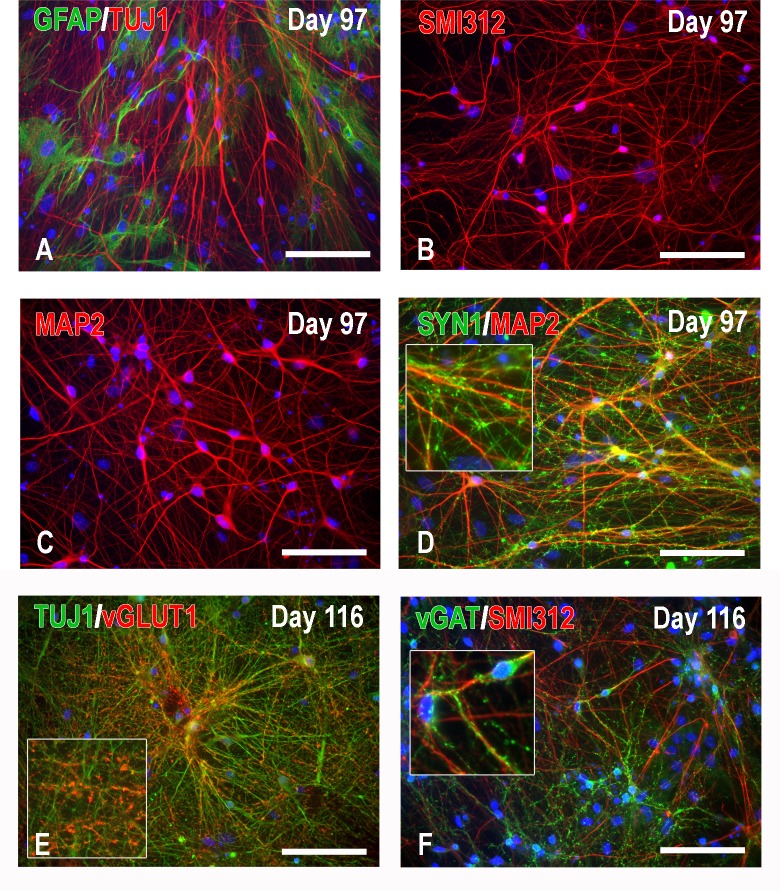
Characterization of hNP-derived neurons co-cultured with mouse astrocytes by immunocytochemistry at an advanced stage (Days 97 and 116).The use of the co-culture system with CD1 astrocytes (A) greatly reduces aggregation and promotes neuronal differentiation in the form of nicely separated mature neurons expressing advanced neuronal signatures such as phosphorylated neurofilaments M and H (B: SMI312 immunoreactivity), MAP2 (C), and SYN1 (D, in conjunction with MAP2). Neurotransmitter markers consistent with excitatory or inhibitory neurotransmission such as vGLUT1 and vGAT are also abundantly expressed in these cultures (E and F). Note the vesicular nature of vGLUT1 and vGAT immunoreactivity. Scale bars: 100μm.